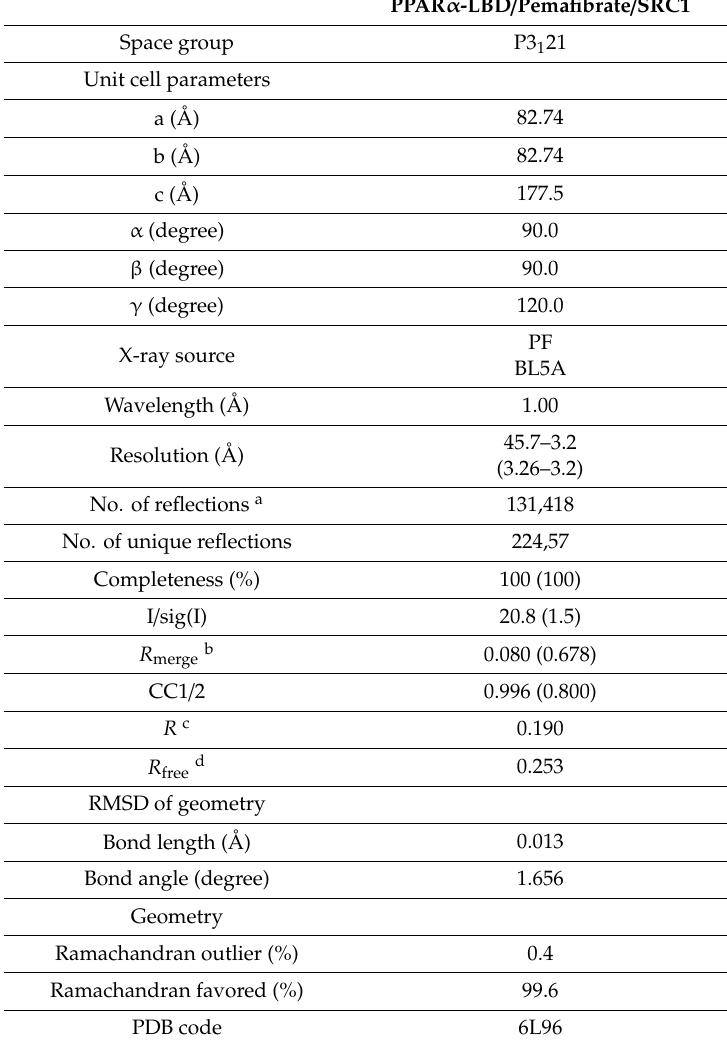
Table 2. Statistics of X-ray di ff raction data collection for PPAR α -LBD (194-468) complexed with pemafibrate and coactivator peptide,